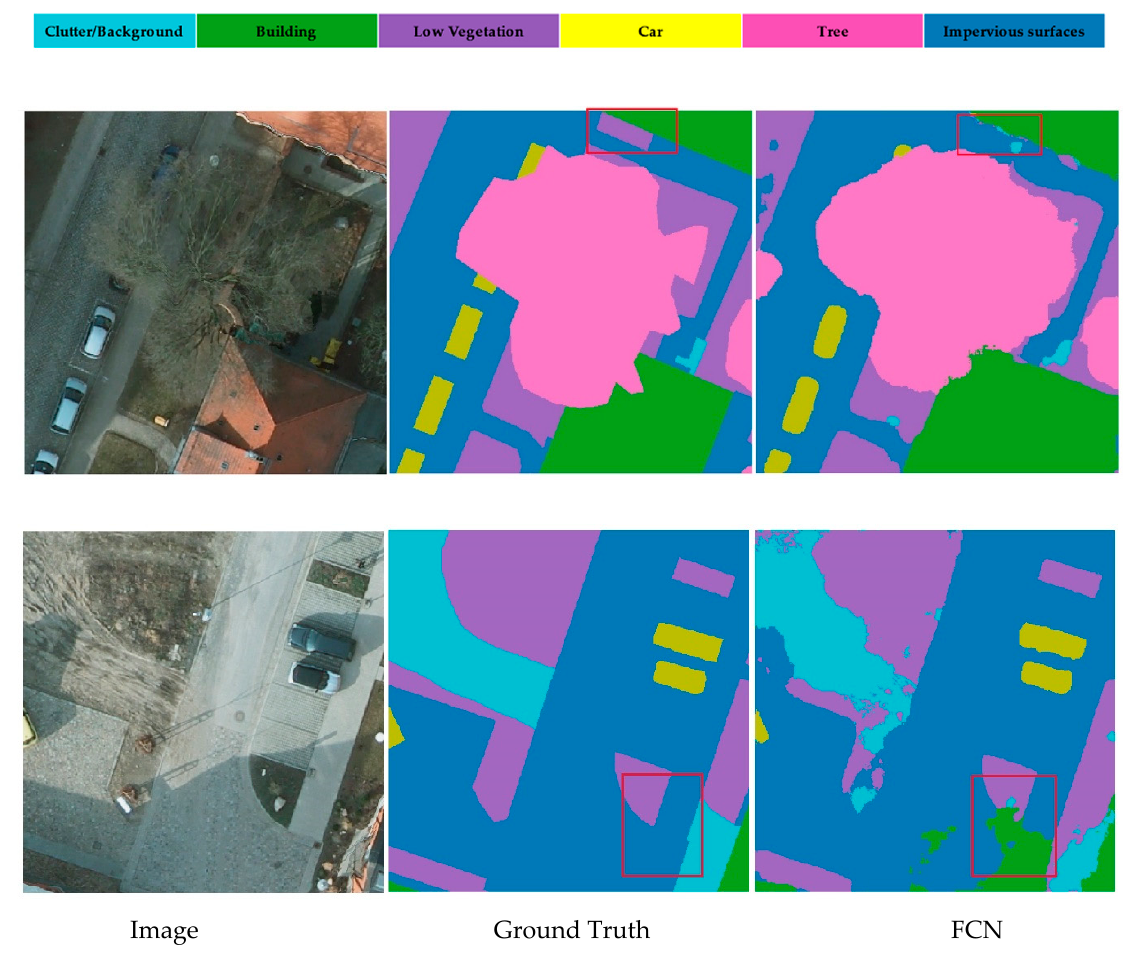
Image Ground Truth FCN Figure 4. FCN model does not take the surrounding context and specific output category into consideration. Thus, there exists some mismatched relationship during inference.